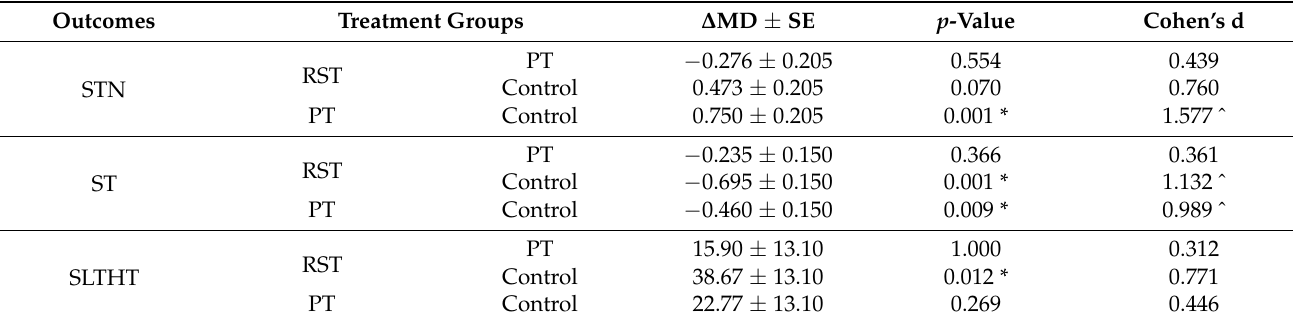
Table 4. Pairwise comparisons of the post test scores (at 6 weeks) for the outcomes of strength (STN), resisted sprint (ST), and muscle performance (SLTHT) between the groups using Bonferroni’s post hoc test. Cohen’s d test was applied for measuring the effect size between the two groups.